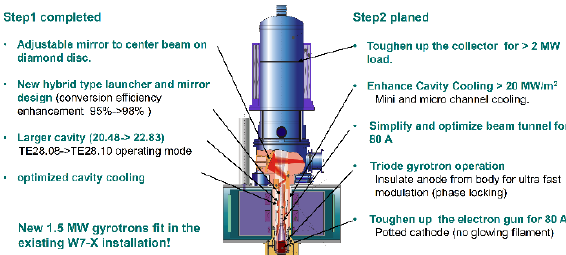
Fig. 1. Improvements in gyrotron design realised in step 1 and planned for step